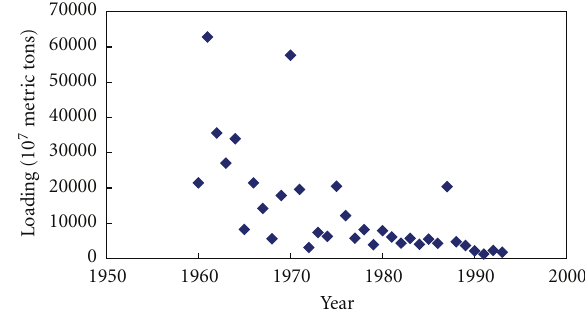
Figure 2: Total sediment loading at Nakhon Sawan from 1960 to 1993 (cited from [1]).